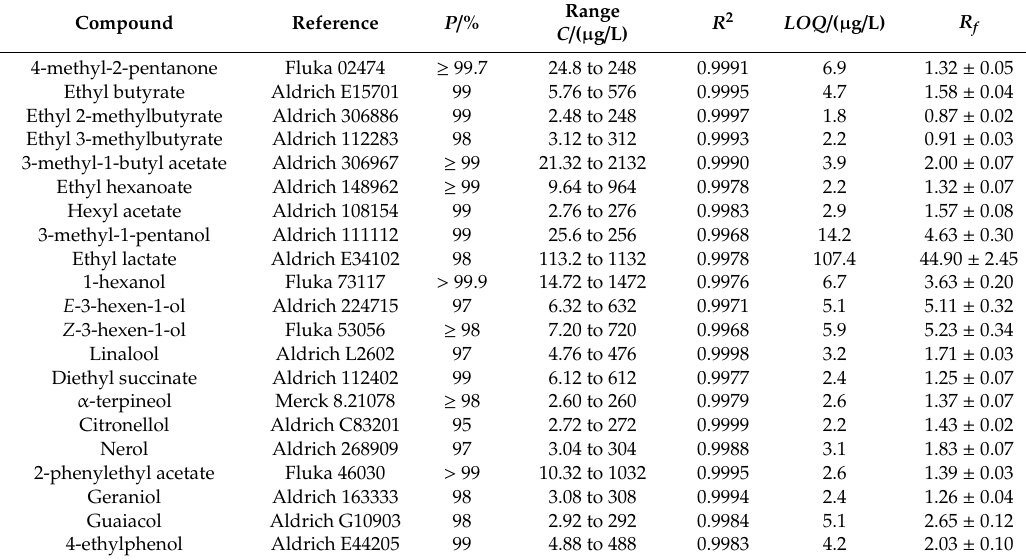
Table 1. Reference, purity ( P ), and concentration range ( C ) for each analyte, and Pearson correlation coe ffi cient ( R 2 ), limit of quantification ( LOQ ), and response factor of the method ( R f ), with respective confidence limits ( p = 0.05), obtained from the calibration